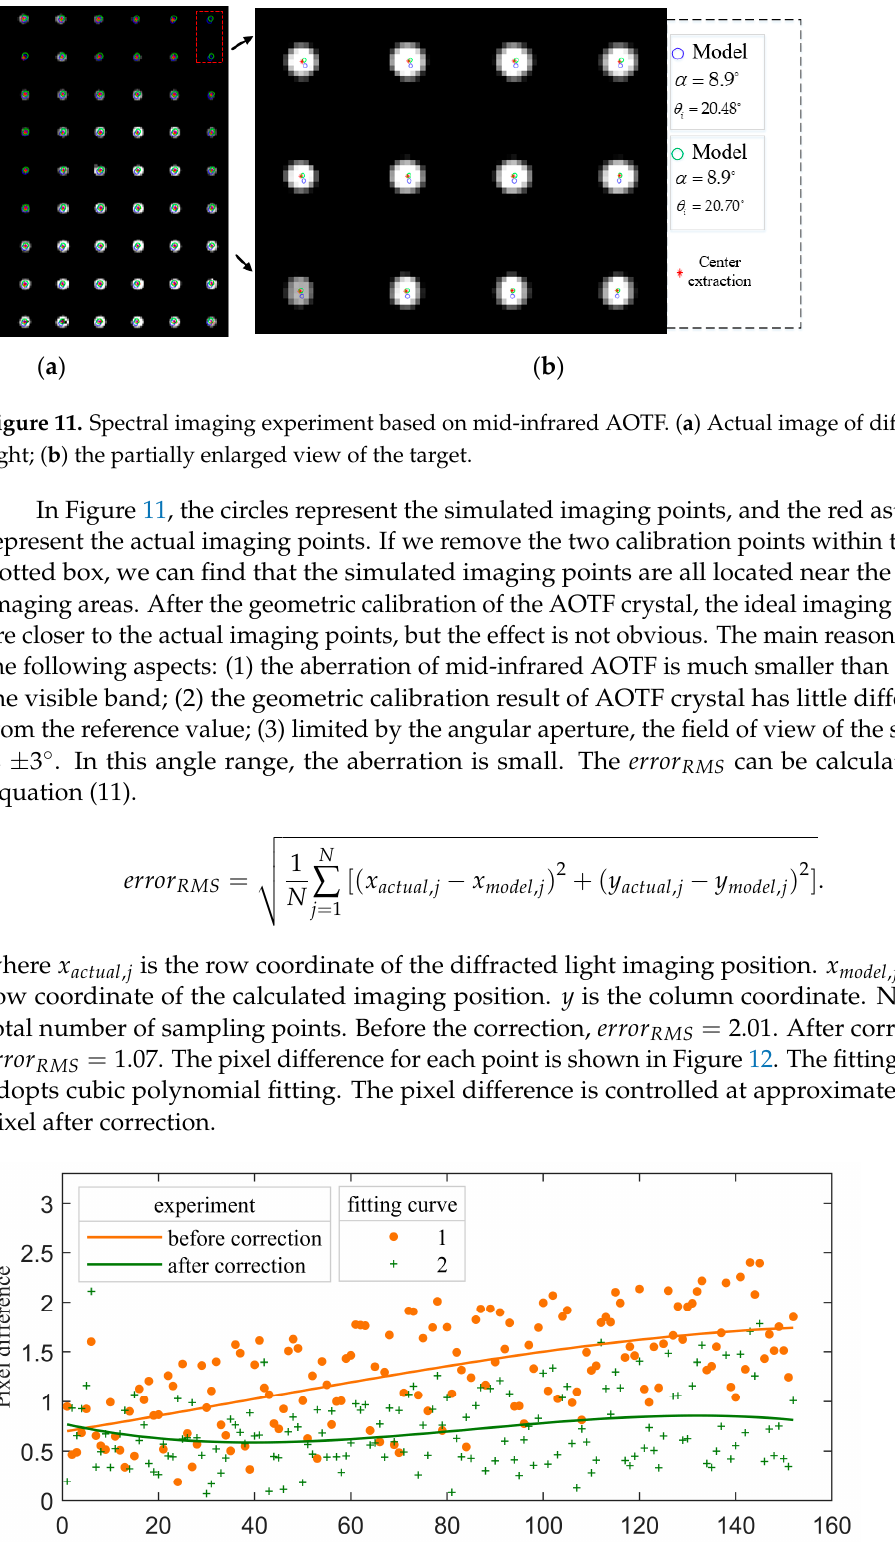
Figure 12. The pixel difference for each point.